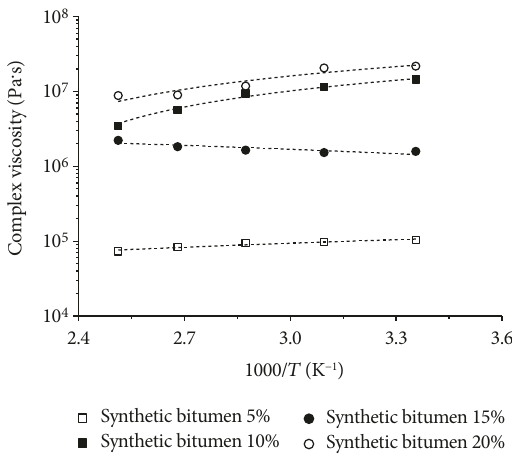
Figure 3: Complex viscosity, η ∗ 1/ T , for sample